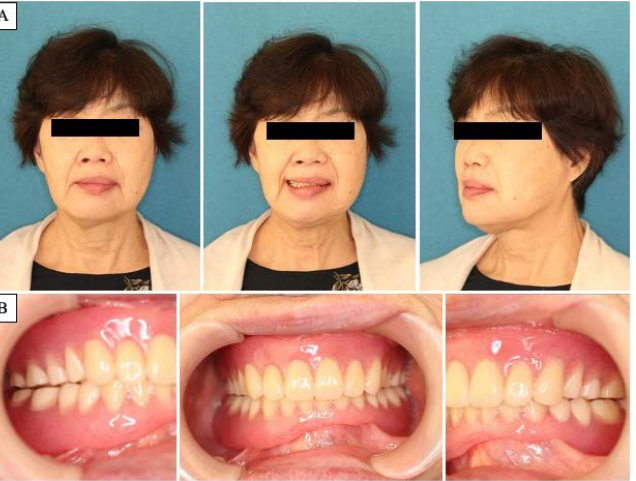
Figure 6. Postoperative clinical features. ( A ): Postoperative facial image. Improvement in facial symmetry is noted. ( B ): Prosthodontist adjusted the denture to achieve a stable jaw position.